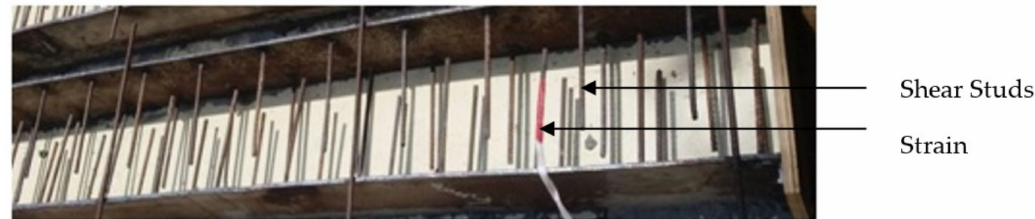
Figure 4. Beam specimen with shear